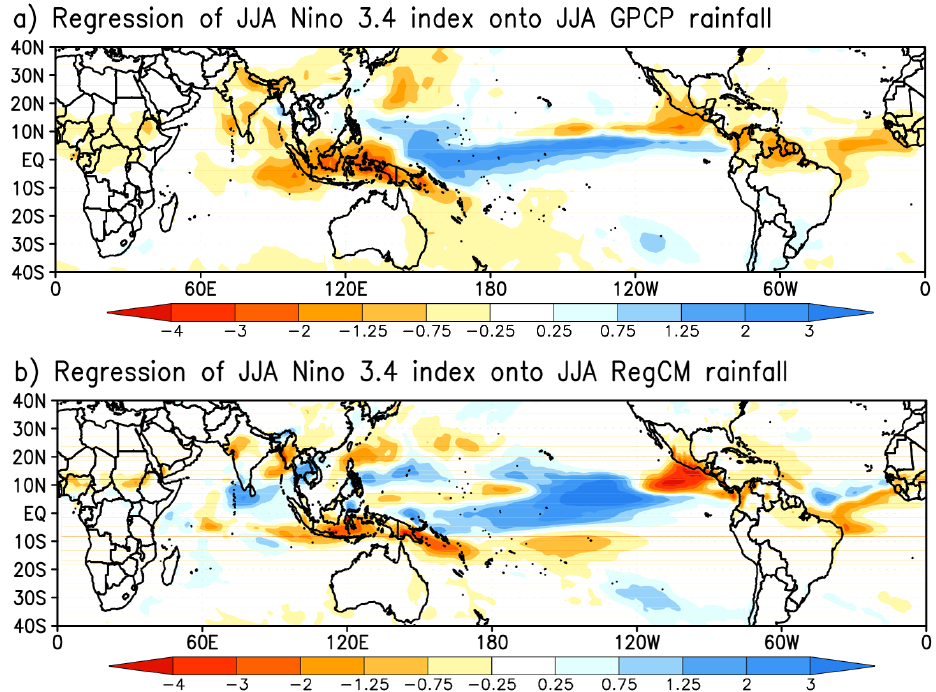
Figure 13. Regression of JJA Niño 3.4 index onto JJA rainfall for 1982–2009. (a) GPCP; (b) Reg-TB ensemble average. Table 1. 95% significance test of the correlation between Niño 3.4 anomalies and rainfall at the upper catchment of the Blue Nile (see Fig. 1) for the nine simulation members and for the ensemble average. The correlation is calculated over the period 1982–2009. Rainfall Season of Niño 3.4 JFM FMA MAM AMJ MJJ JJA JAS ASO SON